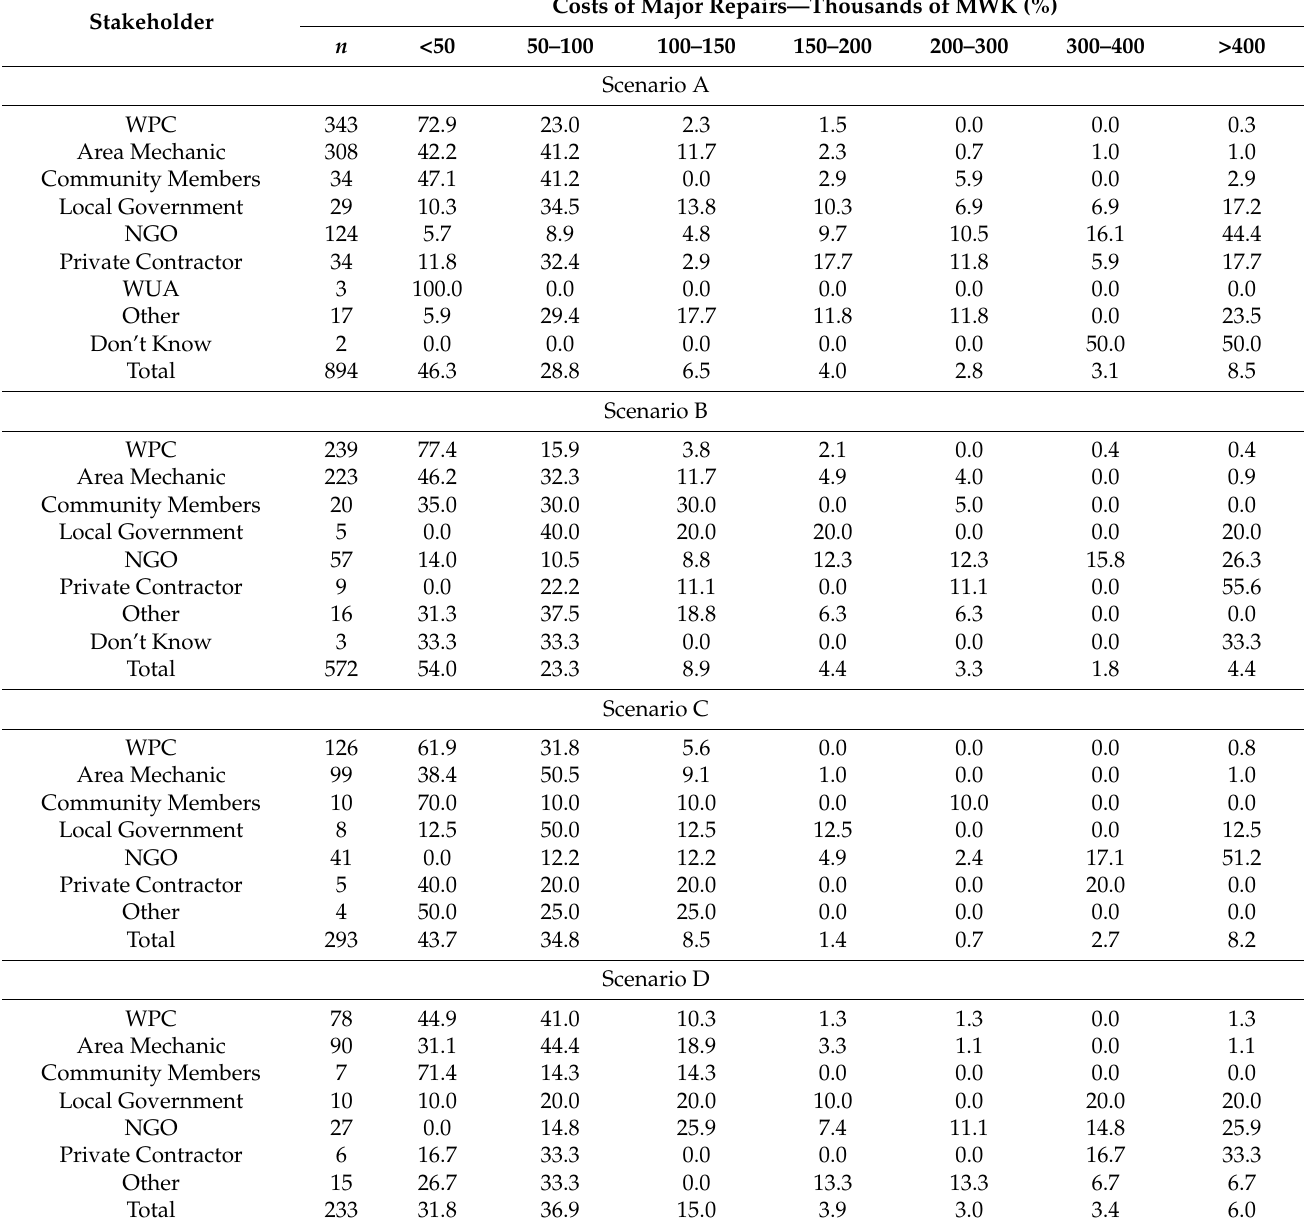
Table 2. Stakeholders conducting major repairs by cost